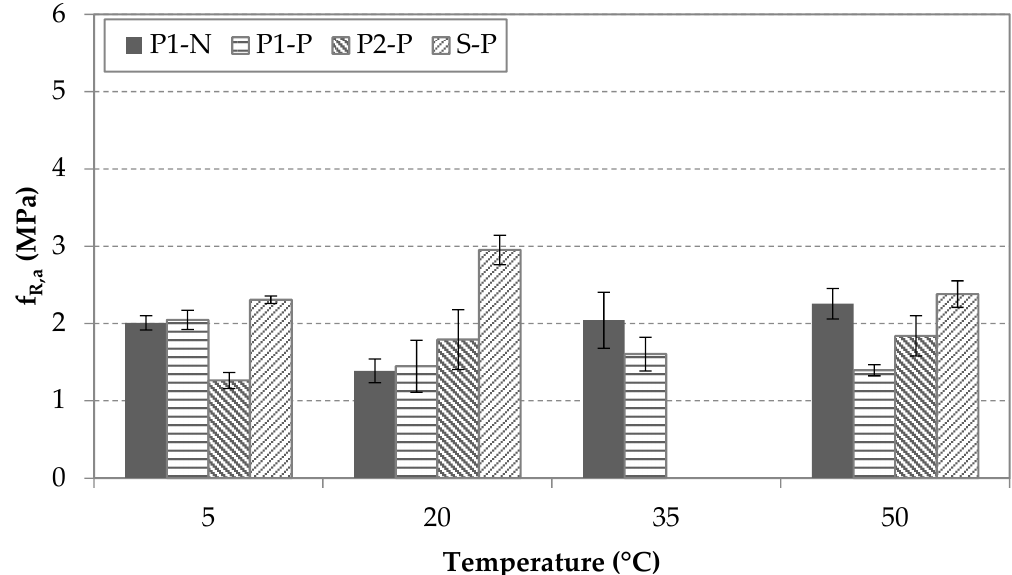
Figure 9. Results of f R,a for each type of fiber and condition at different temperatures.